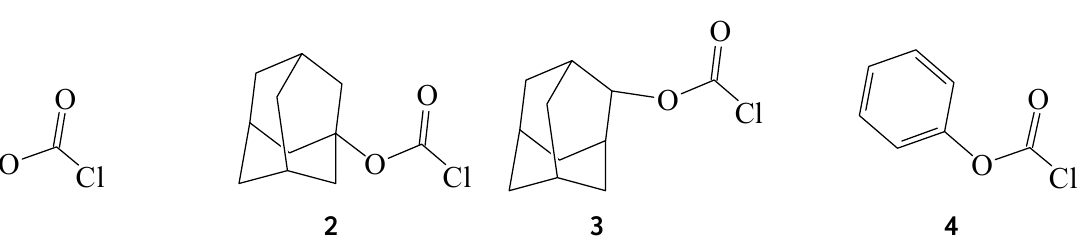
Figure 1. Molecular structures of isopropyl chloroformate ( 1 ), 1-adamantyl chloroformate ( 2 ), 2-adamantyl chloroformate ( 3 ), and phenyl chloroformate ( 4 ).